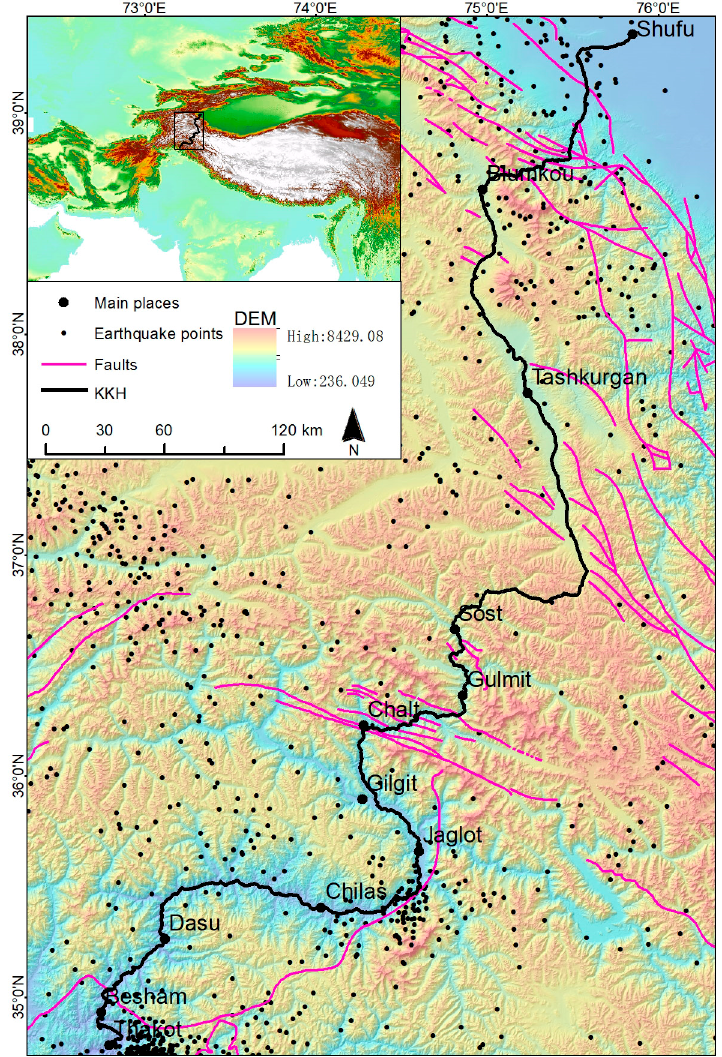
Figure 1. Location of the study area and distributions of faults, the KKH, earthquake sites, and the major settlements. (The Digital Elevation Model (DEM) data were provided by the International Scientific and Technical Data Mirror Site, Computer Network Information Center, Chinese Academy of Sciences, http://www.gscloud.cn; faults were provided by China Geological Survey; the earthquake sites were from earthquake database supplied by United States Geological Survey (USGS), and the sites with magnitude above 4 on the Richter scale since 2000 were selected, https://earthquake.usgs.gov/earthquakes).